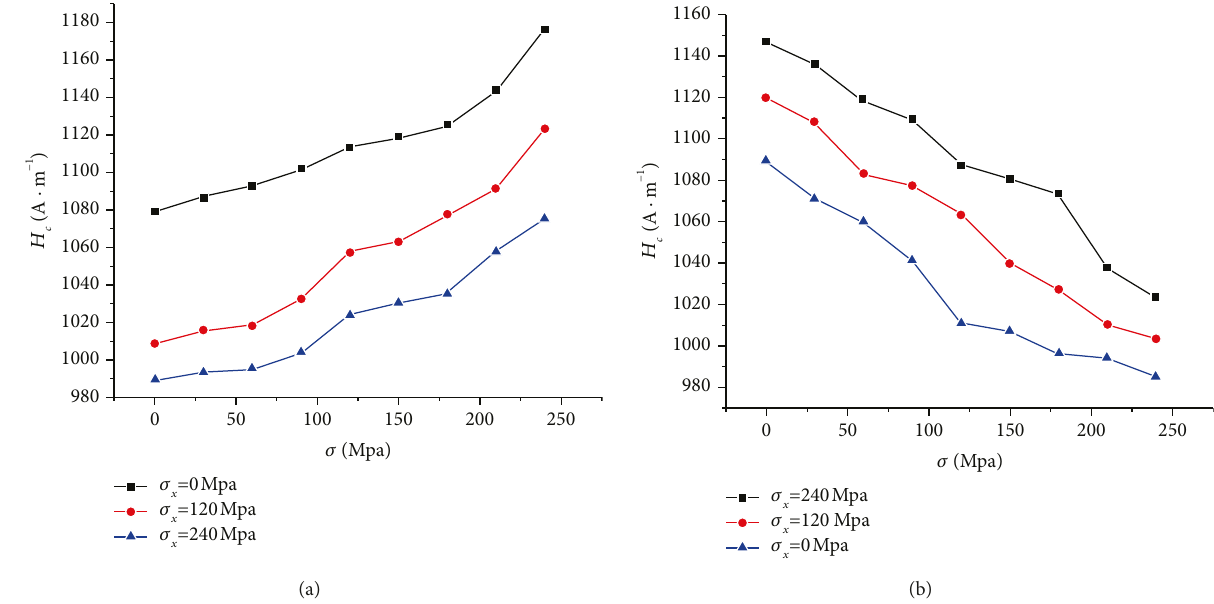
Figure 16: Stress-coercivity relationship of test piece 2 under three σ diagram of test piece 2 under different σ x .